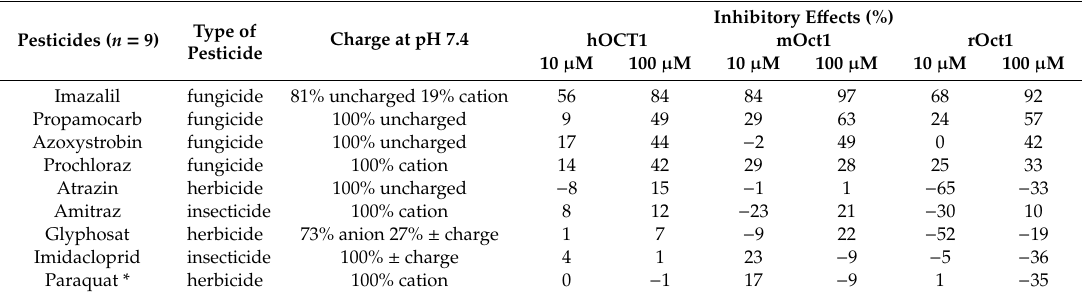
Inhibitory e ff ects of various pesticides to human, mouse and rat OCT1 mediated 3H-MPP uptake.